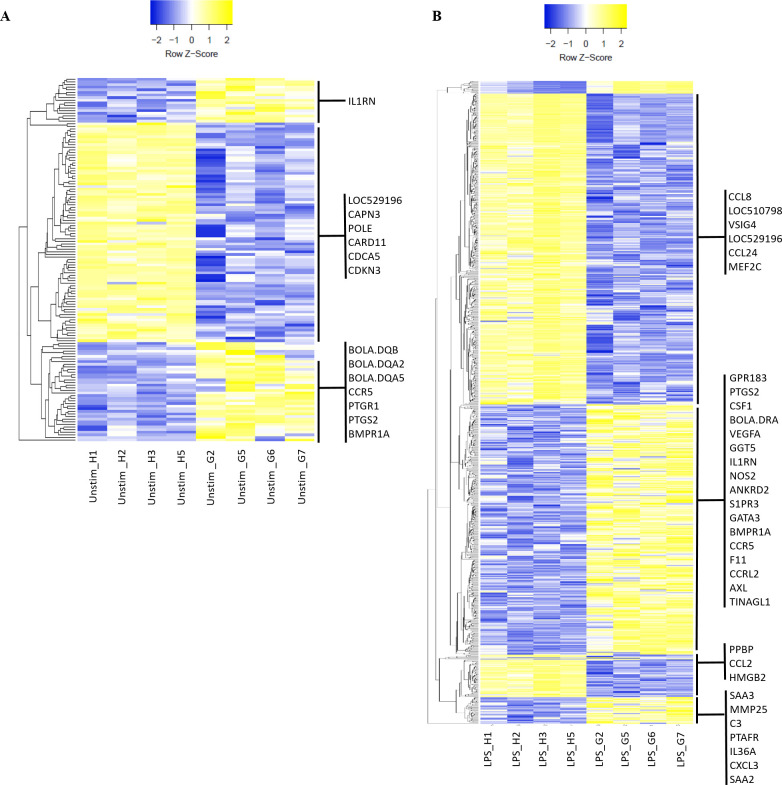
In vitro stimulated MDMs transcriptional profile of Holstein and Gir breeds.Heatmap of RNA sequencing data characterized as row-wise Z scores in CPM. Heatmap Z-scores were calculated for each row (each gene) and each column (each sample) and plotted according to the normalized expression values. (A) Unstimulated MDMs from Holstein (n = 4) and Gir (n = 4) breeds displayed 139 DEGs (FDR<0.05, LogFC≥1) related to biological processes of antigen processing and presentation via MHC class II, immune response and G1/S transition of mitotic cell cycle and (B) LPS stimulated MDMs from Holstein (n = 4) and Gir (n = 4) breeds displayed 920 total DEGs (FDR<0.05, LogFC≥1) related to biological processes of inflammatory response, regulation of cell proliferation and cell chemotaxis. The main DEGs were highlighted according to the enriched biological processes (P<0.05 and FDR≤0.05). H1, H2, H3, H5: Holstein samples; G2, G5, G6, G7: Gir samples.